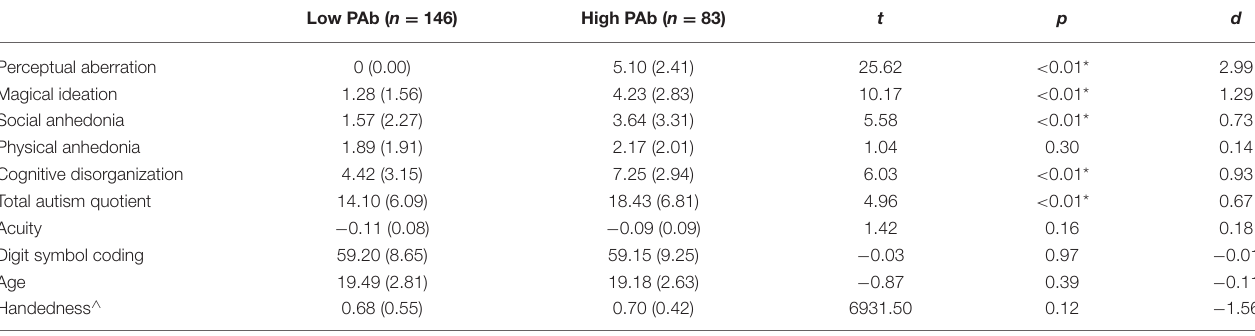
TABLE 1 | Participant characteristics (Mean and SD) in high and low Perceptual Aberration